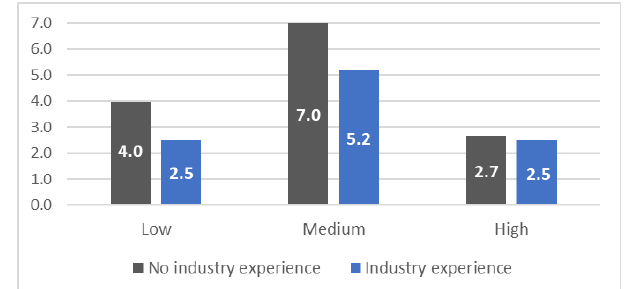
Fig. 9. Mean of the number of defects per severity level in models.